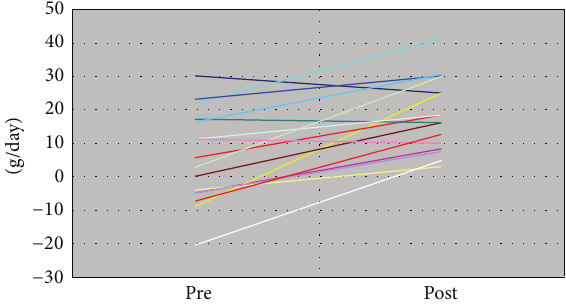
Figure 1: Changes in body weight gain per day before and after duodenal tube